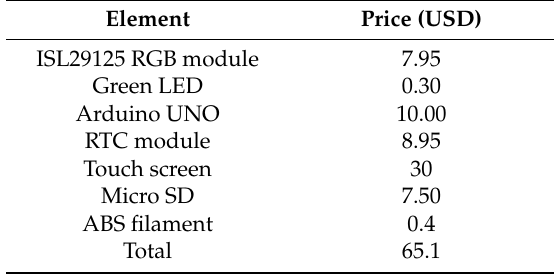
Table 3. Average cost of colorimeter